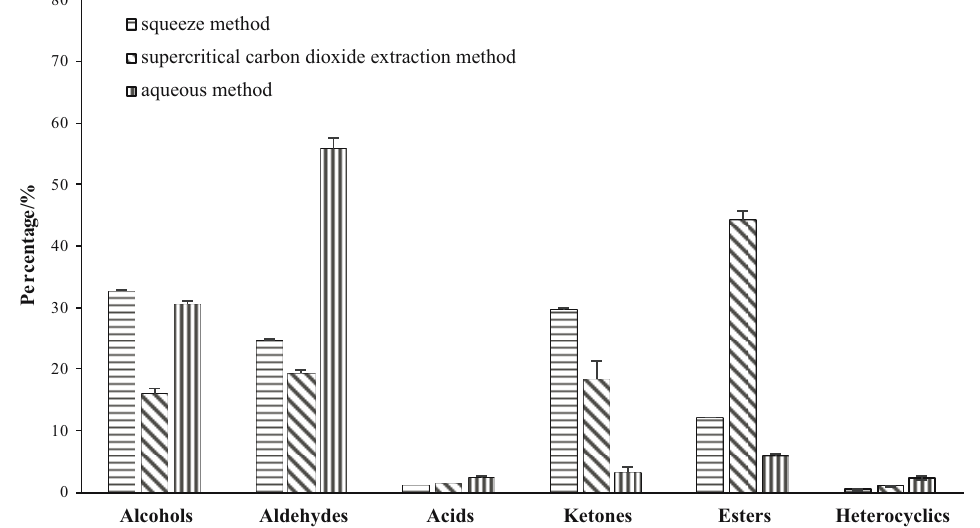
Figure 3: Analysis of proportion of VOCs in avocado oil obtained from di ff erent extraction